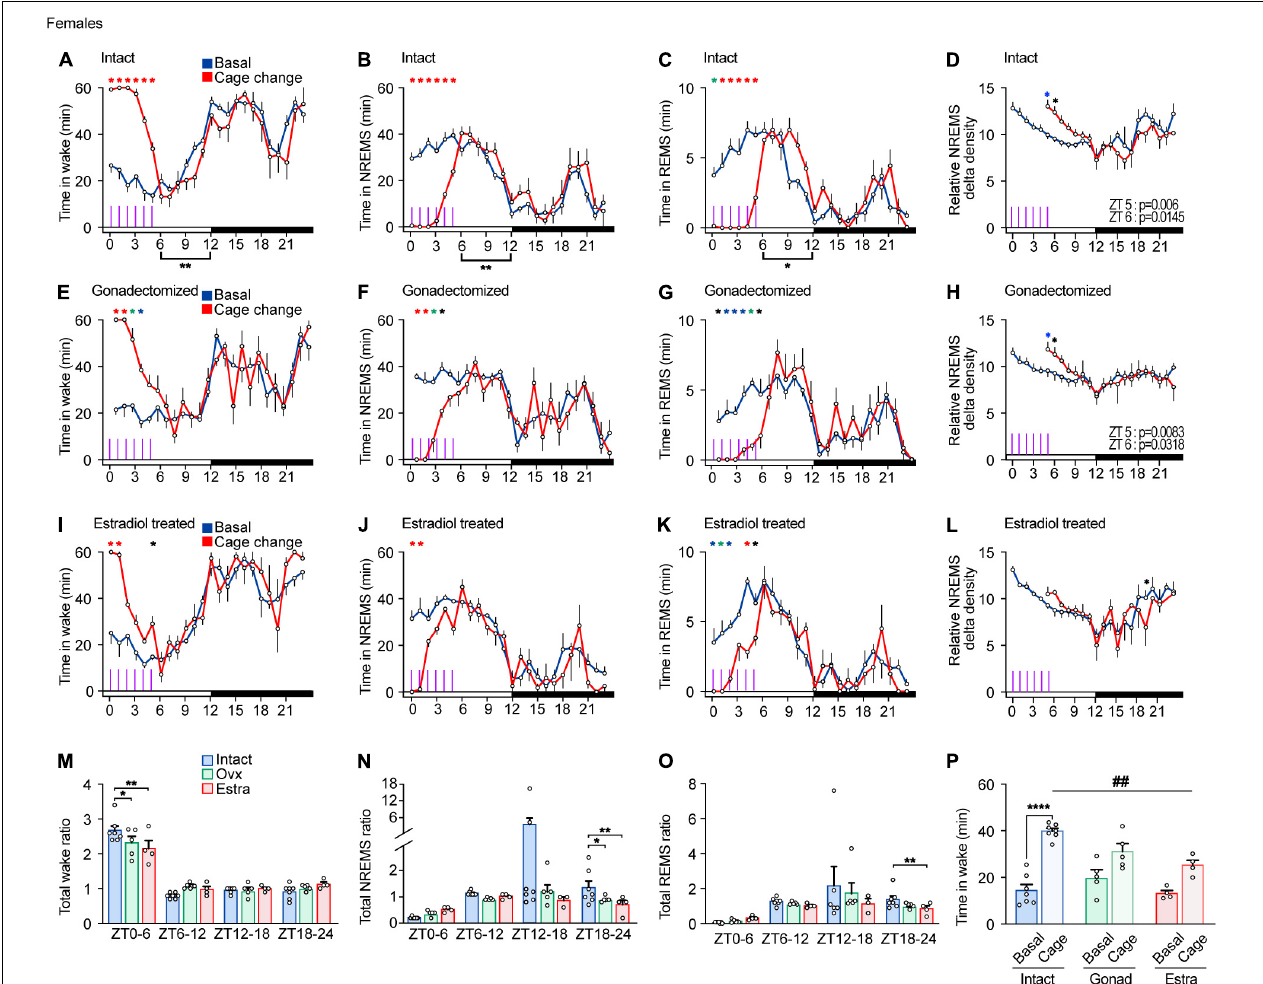
FIGURE 6 | Sleep/wake behavior of female mice in response to repeated cage changes. (A–D) Hourly wake time (A) , NREMS time (B) , REMS time (C) , and NREMS delta density (D) under the baseline condition and with six hourly cage changes from ZT0 in intact female mice; seven mice. Two-way ANOVA followed by Sidak’s test. (E–H) Hourly wake time (E) , NREMS time (F) , REMS time (G) , and NREMS delta density (H) under the baseline condition and with six hourly cage changes from ZT0 in gonadectomized female mice; five mice. Two-way ANOVA followed by Sidak’s test. (I–L) Hourly wake time (I) , NREMS time (J) , REMS time (K) , and NREMS delta density (L) under the baseline condition and with six hourly cage changes from ZT0 in estradiol-supplemented gonadectomized female mice; four mice. Purple lines indicate cage changes. Two-way ANOVA followed by Sidak’s test. (M–O) Ratio of total awake time (M) , NREMS time (N) , and REMS (O) to the baseline condition after repeated cage changes. Two-way ANOVA followed by Sidak’s test or Kruskal–Wallis test. (P) Wake time for 2 h from ZT4 under baseline condition and with six hourly cage changes. One-way ANOVA followed by Sidak’s test and Two-way ANOVA followed by Sidak’s test. * P < 0.05; ** P < 0.01; *** P < 0.001. ## P < 0.01. * P < 0.05 (black); * P < 0.01 (blue); * P < 0.001 (green); * P < 0.0001